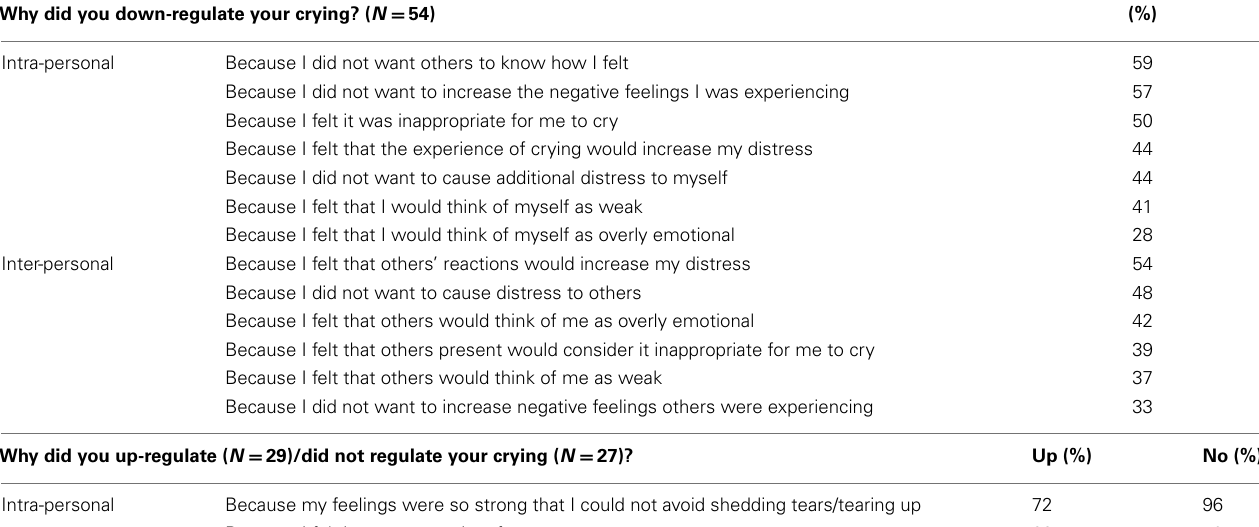
Table 2 | Frequencies of motivations endorsed in the